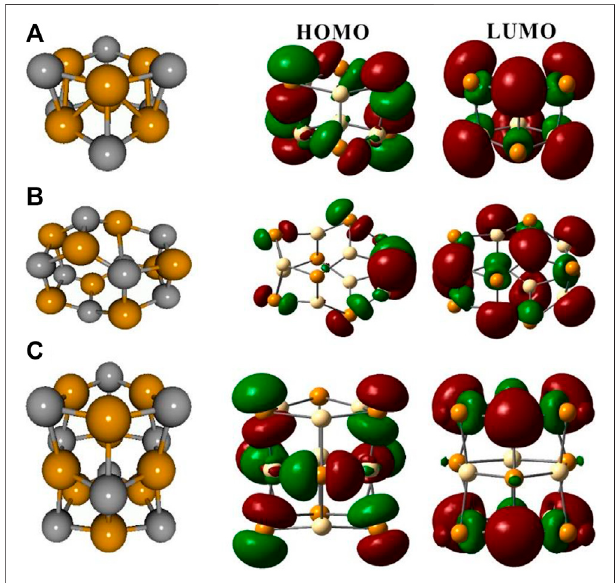
FIGURE2| Optimizedgas-phasestructuresandFrontierorbitalsofbare Cd 6 Te 6 (A) , Cd 8 Te 8 (B) and Cd 9 Te 9 (C) QDs. Dark yellow spheres represent Cd, and gray spheres represent Te.